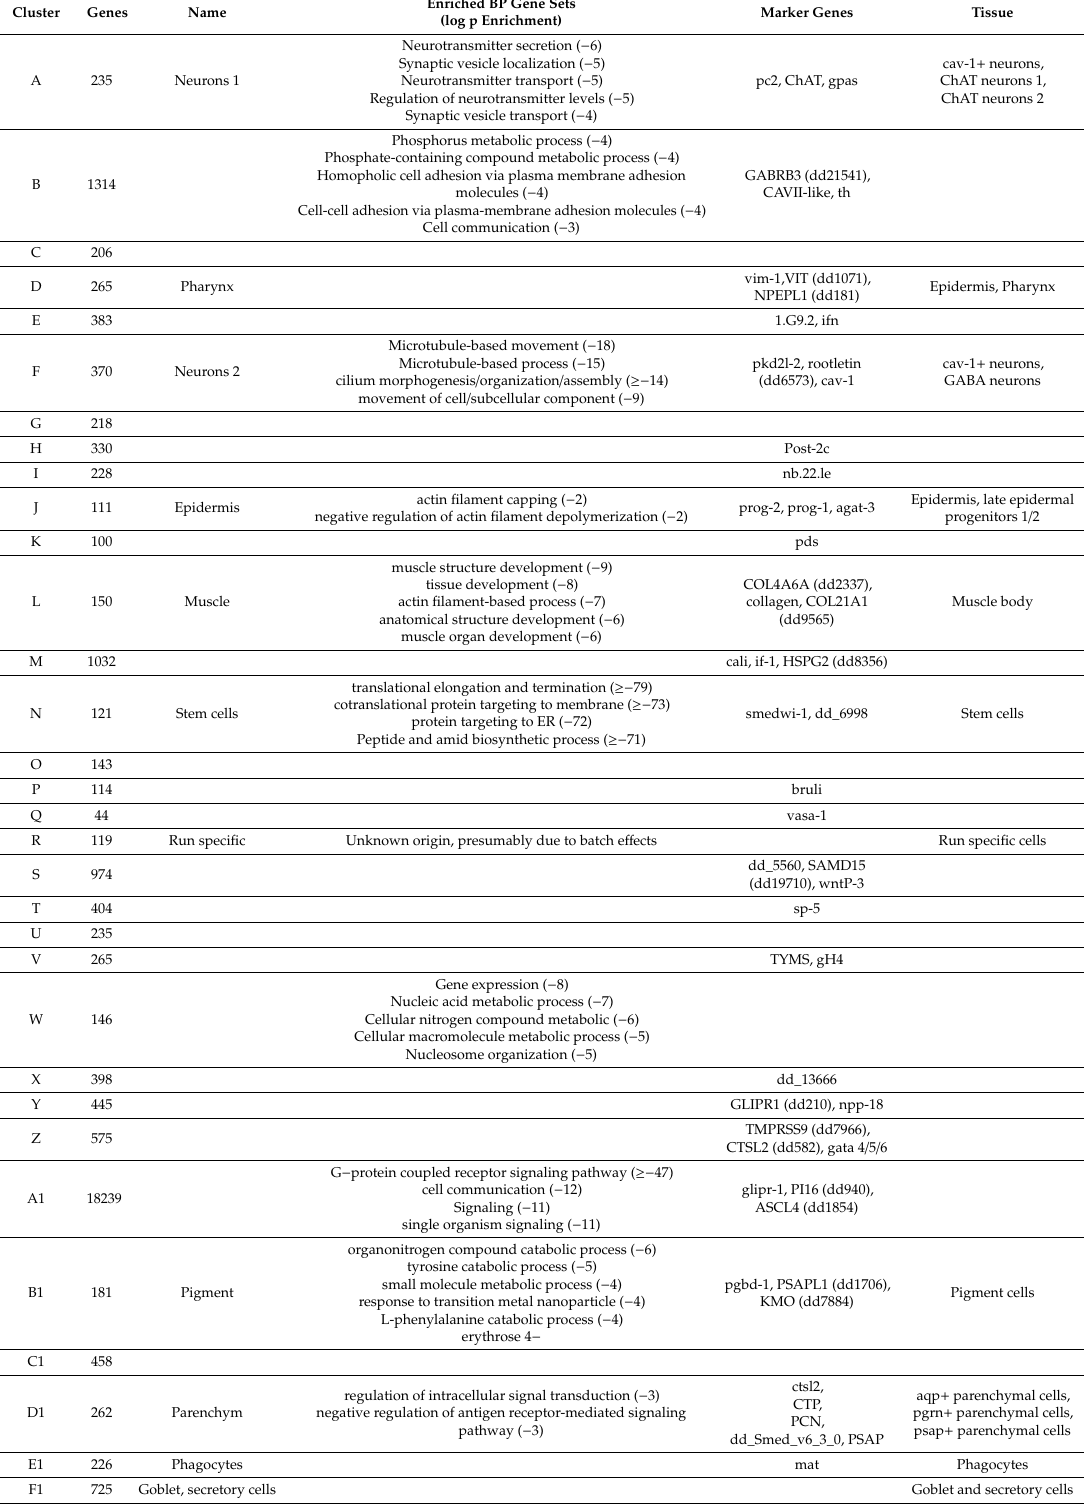
Table 1. Overview of module-wise enriched gene sets and marker genes of planarian sc RNASeq data.